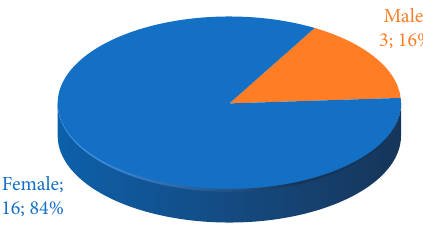
Figure 1: Population distribution by sex.